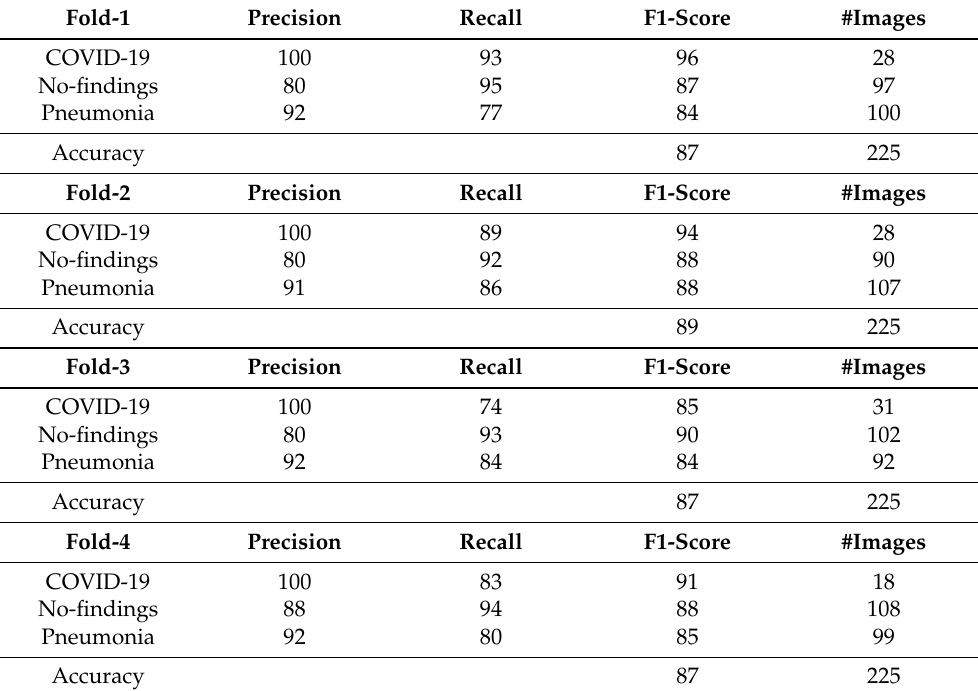
Table 2. Precision, Recall, F1-score and Accuracy of Densenet-161 model with X-ray images and with ADAM